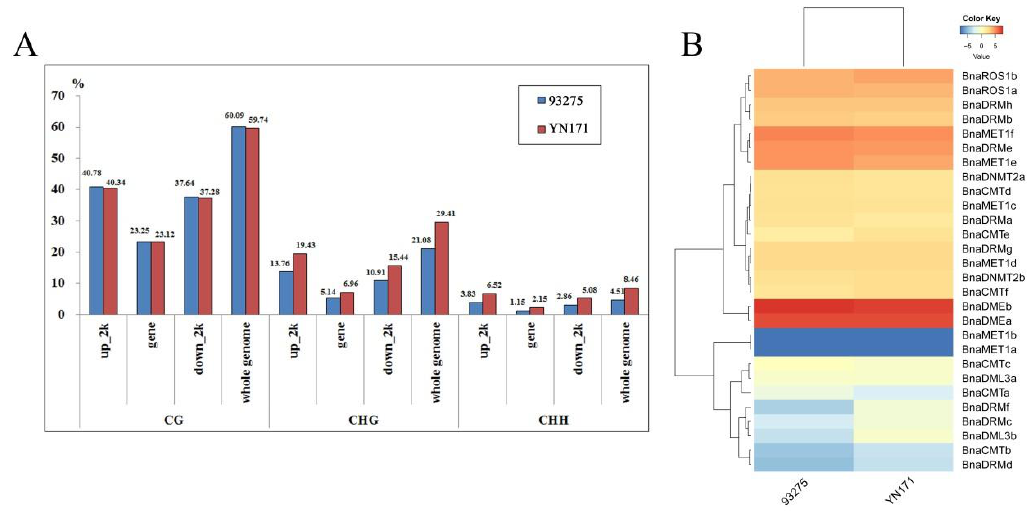
Figure 5. DNA methylation levels and gene expression patterns of 30 DAF endosperm in 93275 and YN171. ( A ) The whole genome DNA methylation levels (%); ( B ) heat map of rapeseed DNA methyltransferases and demethylase families gene expression patterns, color scale bar at the top of each heat map represents log 2- transformed fragments per kilobase of exon per million fragments mapped (FPKM) values of each gene, with warmer colors denoting higher expression.